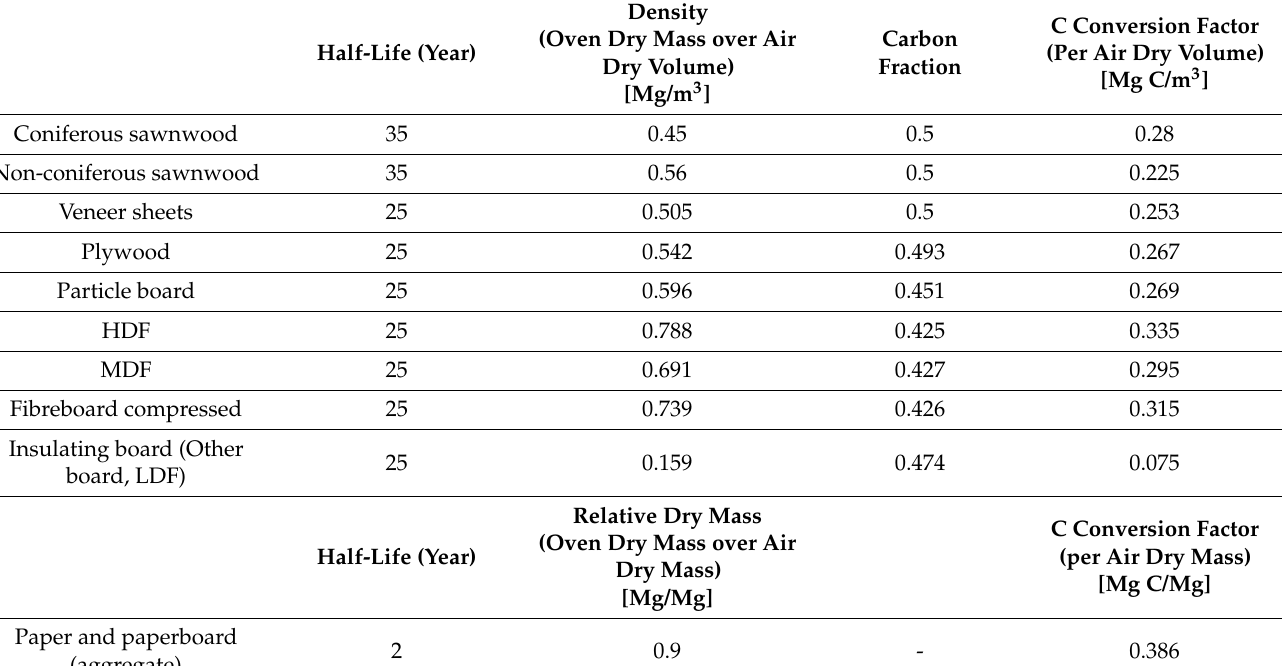
Table 2. Default half-life values and conversion factors recommended by IPCC 2019